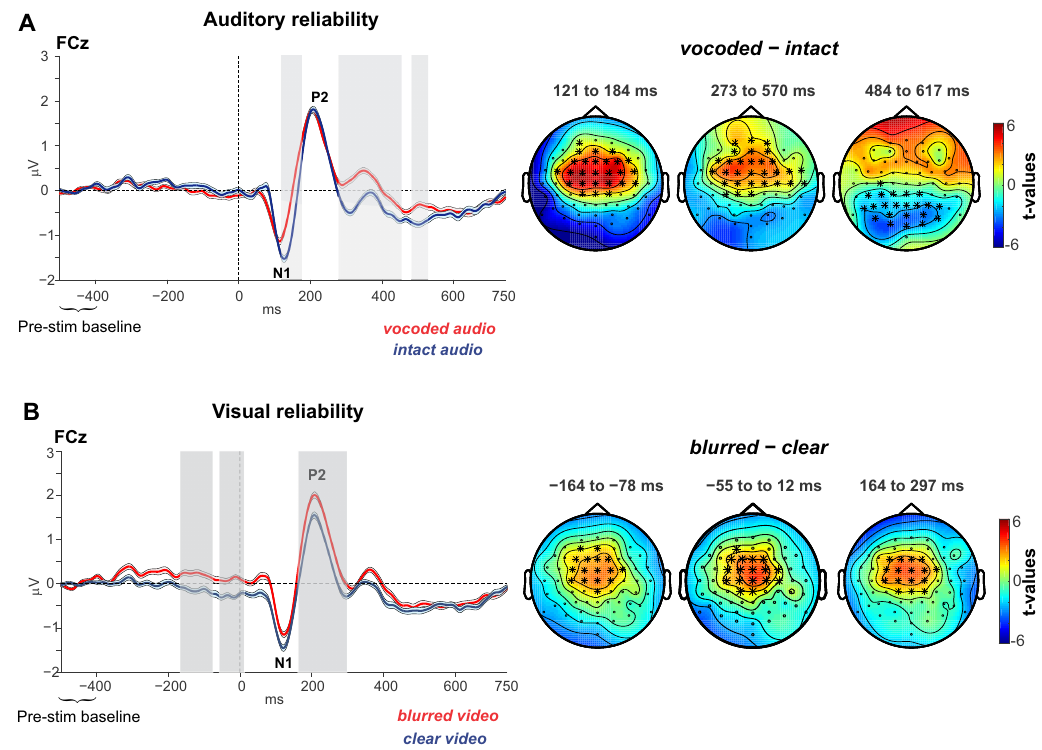
Figure 2. ERP waveforms and t-value topographies distinguishing Auditory reliability conditions ( A ) and visual reliability conditions ( B ). Grey shaded areas indicate significant time windows distinguishingthetwoconditionsatchannelFCz. Ribbonsaroundthewaveformsindicatewithin-subject standard errors. Waveforms were baselined to the